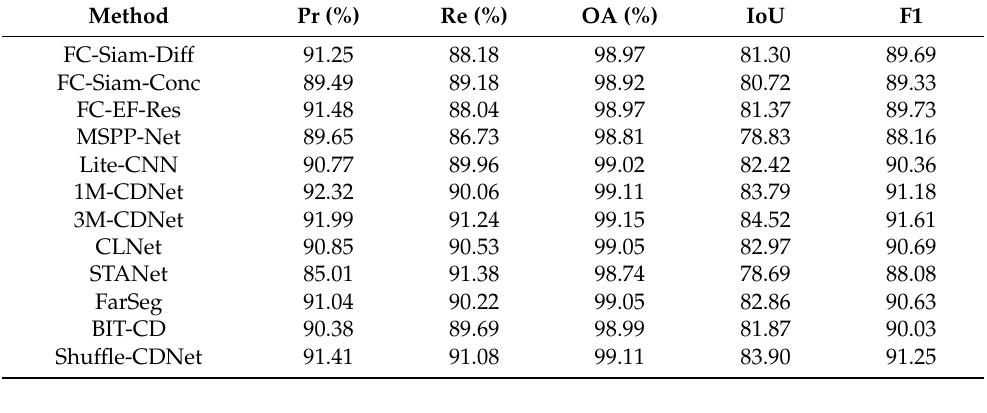
Table 2. Comparison results on the LEVIR-CD dataset.